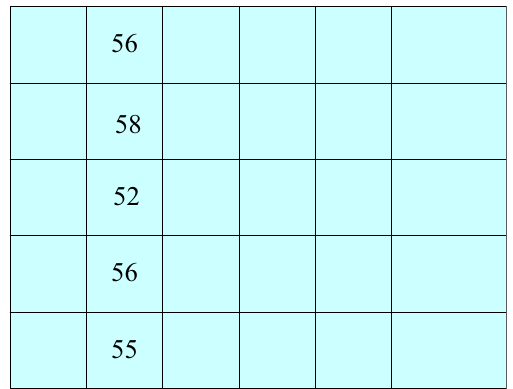
Figure 1. Filter window and grayscale values.